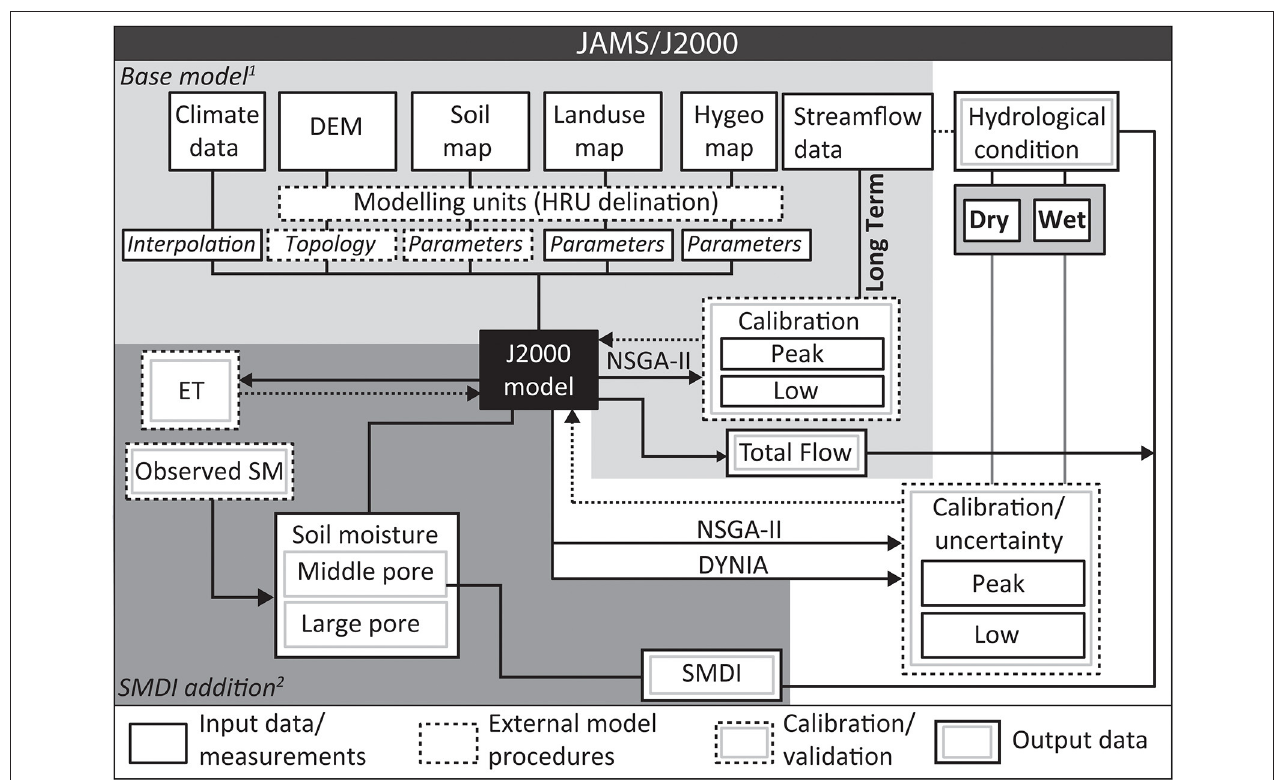
FIGURE 4 | A schematic of the process-oriented JAMS/J2000 distributed rainfall-runoff model (after Krause, 2002), the input data, Hydrological Response Unit Delineation (HRU) and variables required for the base model (after Watson et al., 2020), the addition of the Soil Moisture Deficit Index (SMDI) component (after Watson et al., 2022) used for the assessment of “wet” and “dry” years. The use of the NSGA-II (Non-dominated Sorting Genetic Algorithm: Deb et al., 2002) to refine parameters for “wet” and “dry” years which form the upper and lower bounds ( θ dry ; θ wet ) used in the Dynamic Identifiability Analysis (DYNIA: Wagener et al.,